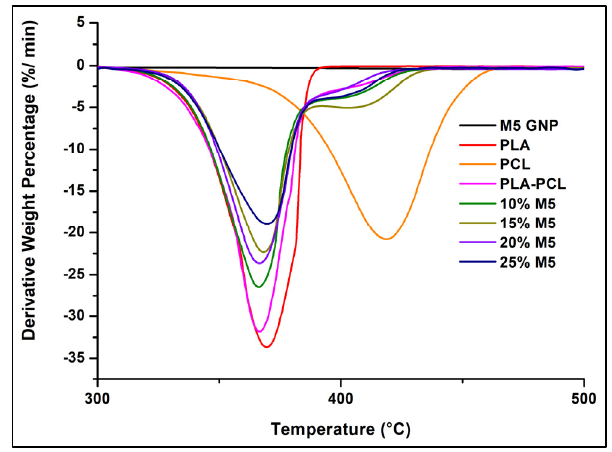
Figure 13. DTG curves (N2 atmosphere, 10 °C.min − 1 ) of GNP, PLA, PCL, and PLA/PCL blends and their composites. Table 3. The TGA results of PLA, PCL, their blends, and their composites.